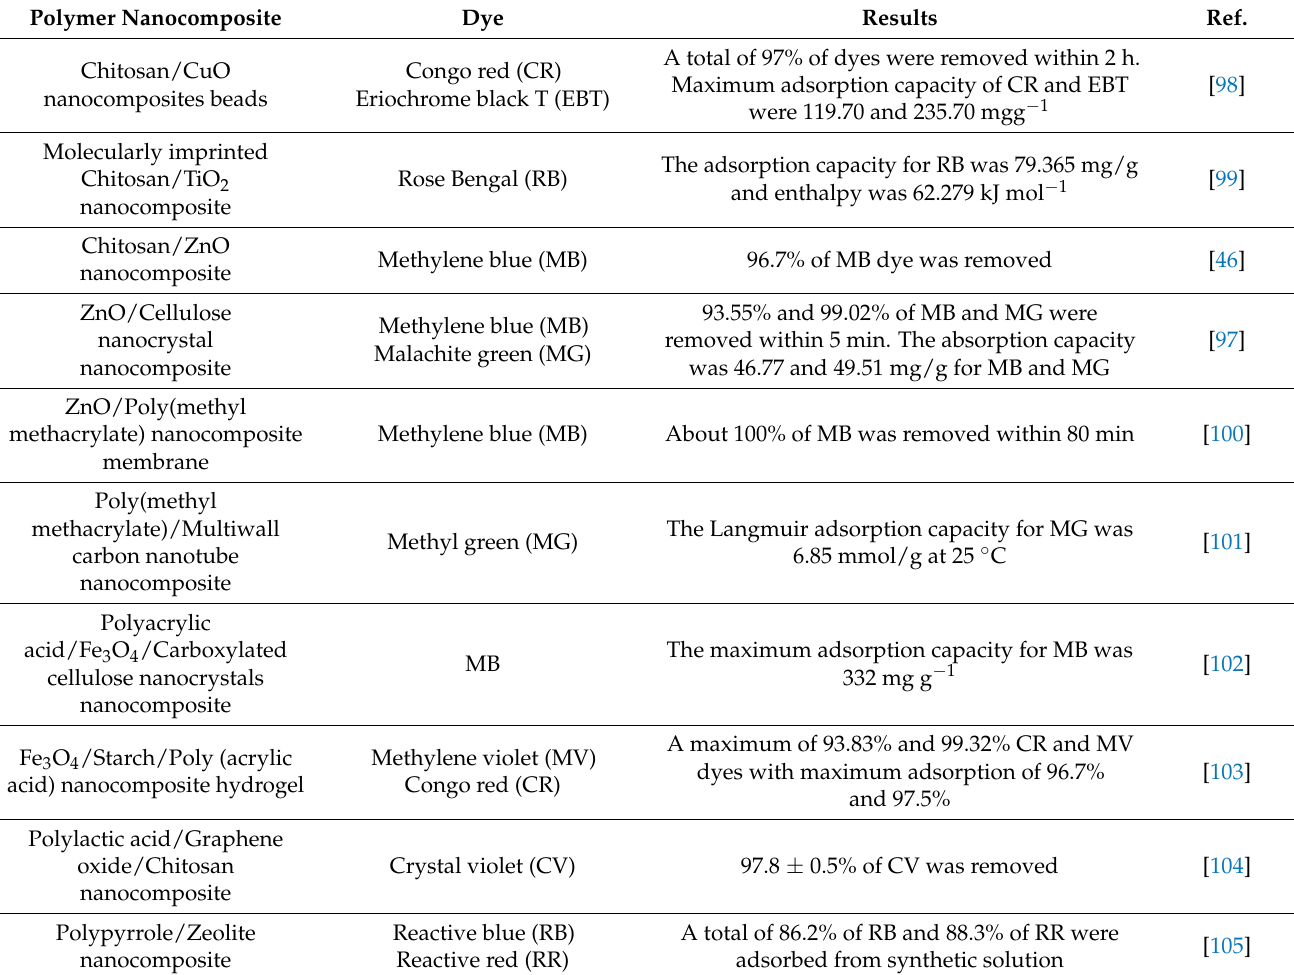
Table 1. Performance of some polymer nanocomposites in dye